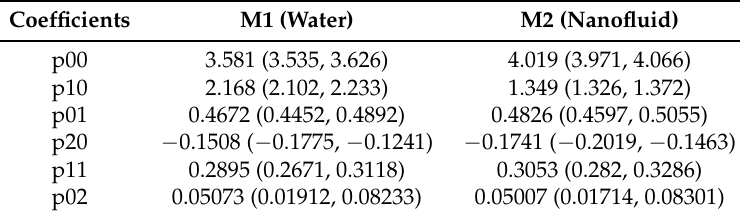
Table 7. Polynomial fit coefficients for water and nanofluid model (within their 95% confidence interval).